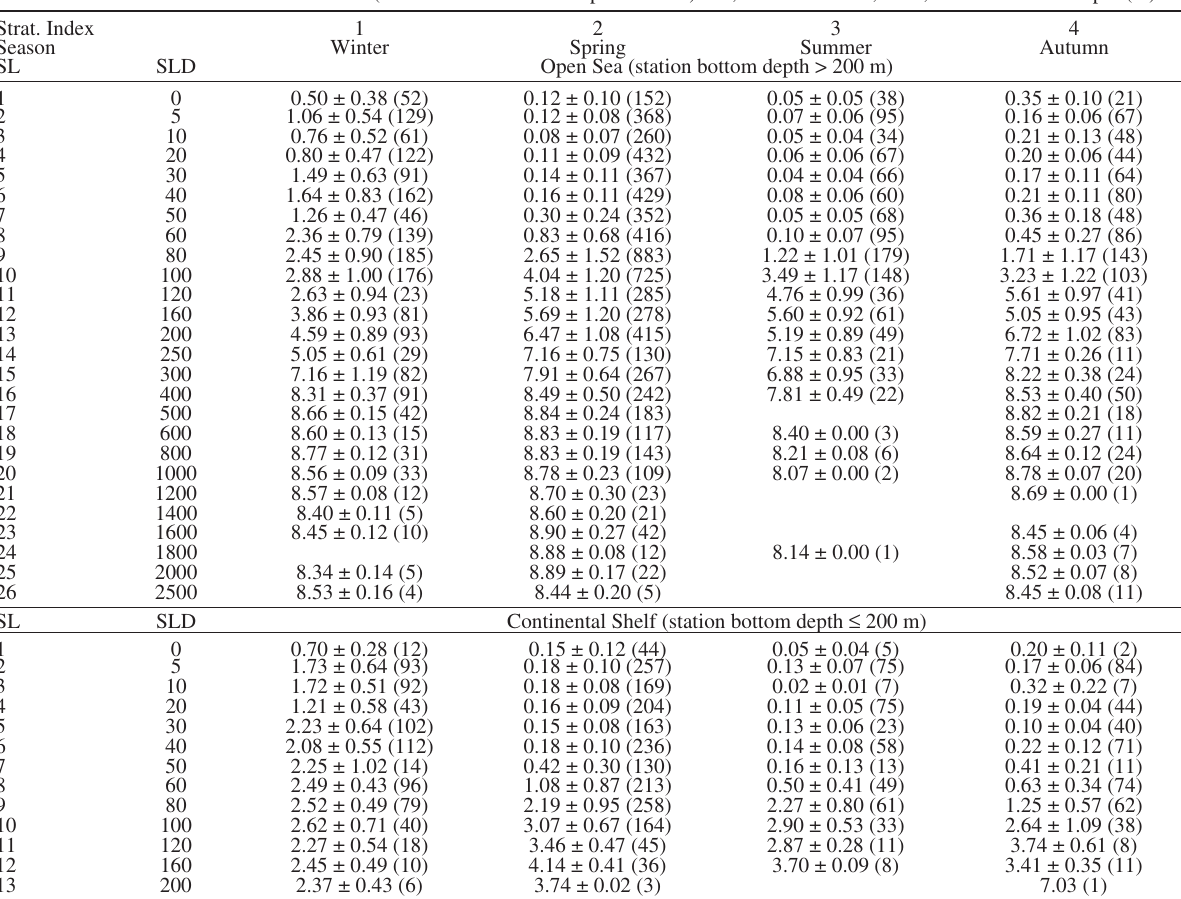
Table S3. – Nitrate concentration (μM) with depth and stratification of the water column in the Catalan Sea (NW Mediterranean Sea). Shown are median ± median absolute deviation (number of data between parentheses). SL, Standard Level; SLD, Standard Level Depth (m). Strat.